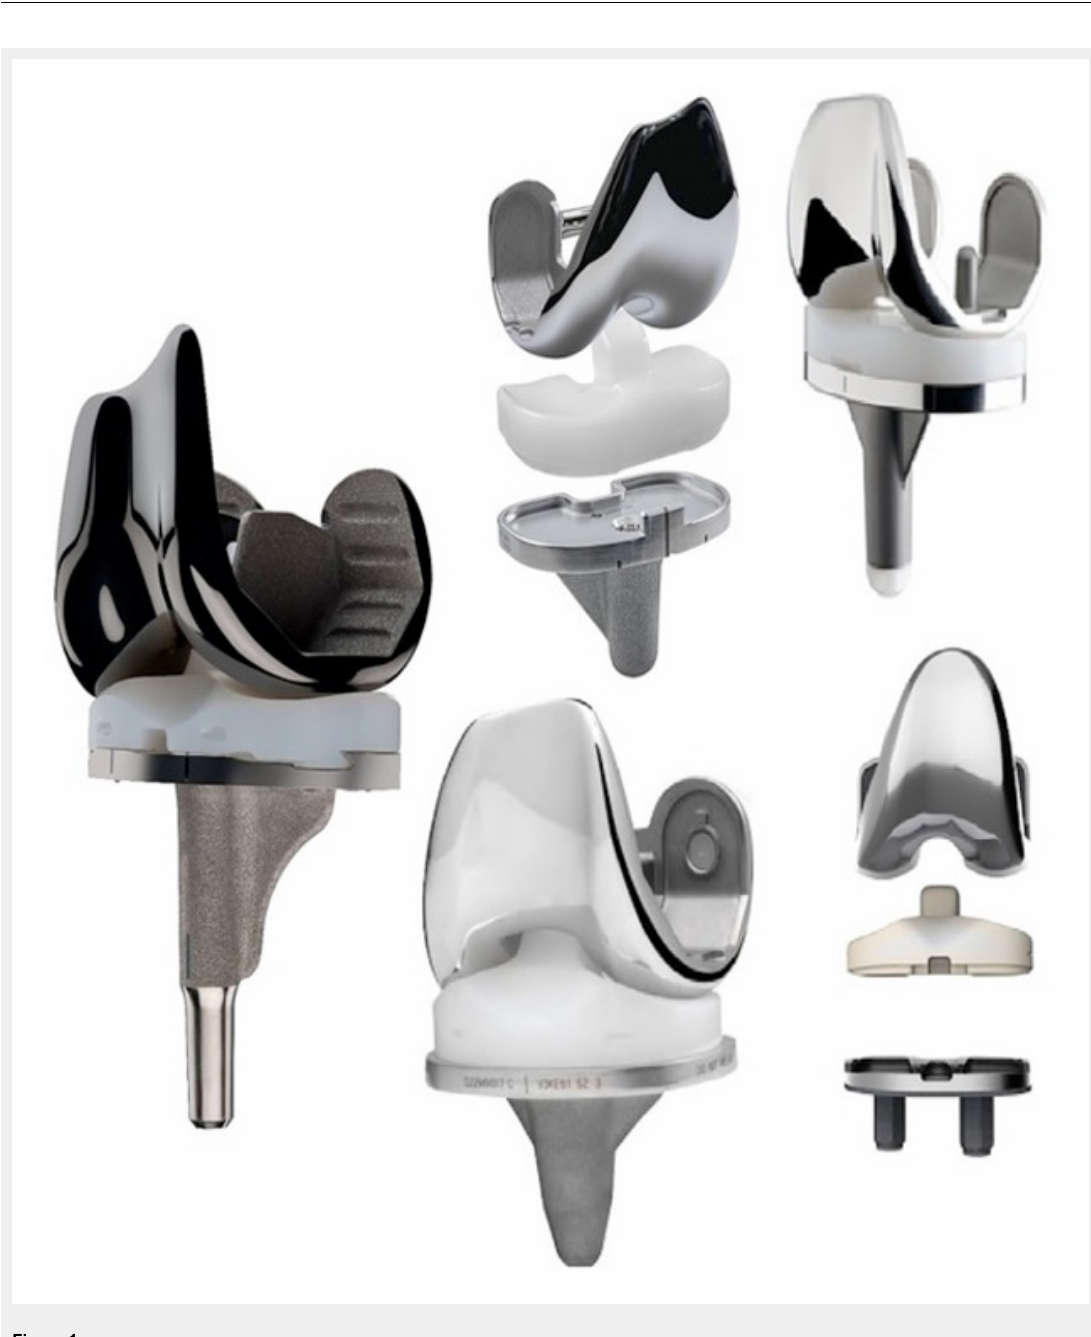
Figure 1 Illustration of a few of the currently available total knee arthroplasty